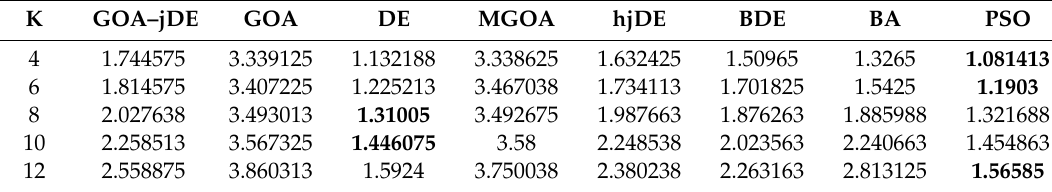
Table 7. The average CPU time of the MCE method at di ff erent threshold levels.